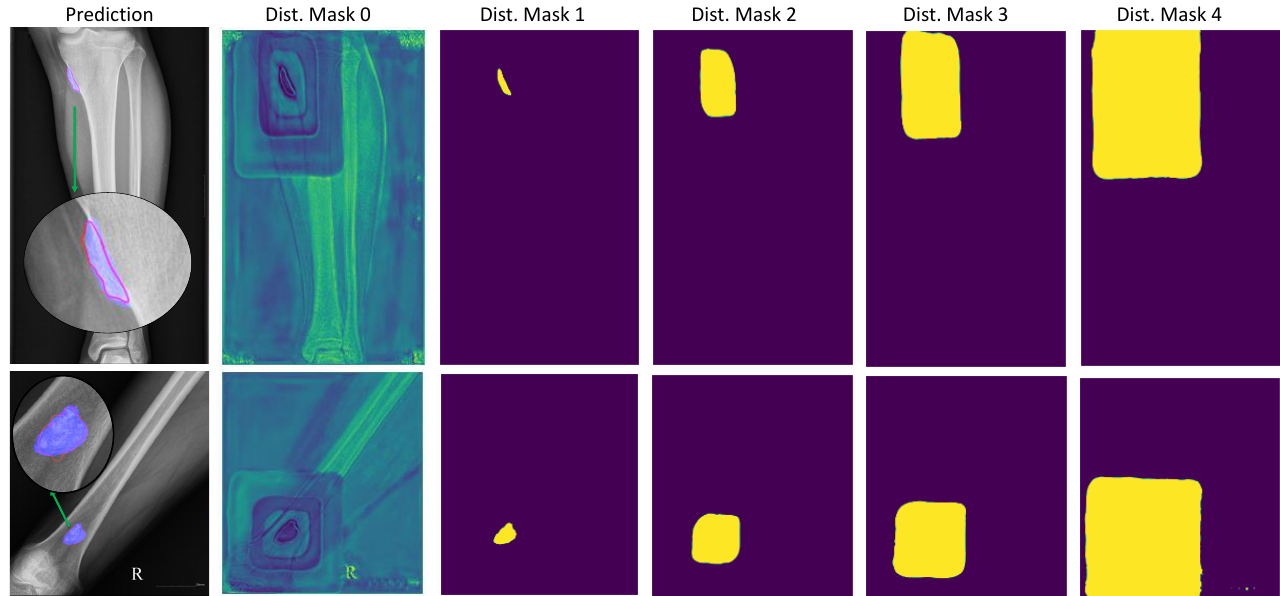
Figure 10. Tumor segmentation result with segmentation branch and high-risk tumor segmentation result with multi-level distance branch. The prediction column shows the original image with a red line for the ground-truth and a blue mask for the tumor mask prediction. The multi-level distance mask has five level masks, with distance mask 0 for the background region, 1 for the tumor region, and 2 through 4 for the three distance levels corresponding to tumor